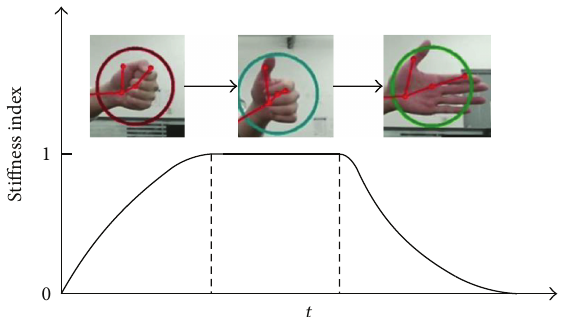
Figure 12: Baxter robot stiffness control by human hand gestures: fist: increasing stiffness with a threshold; thumb-up: holding current stiffness; and finger spread: decreasing